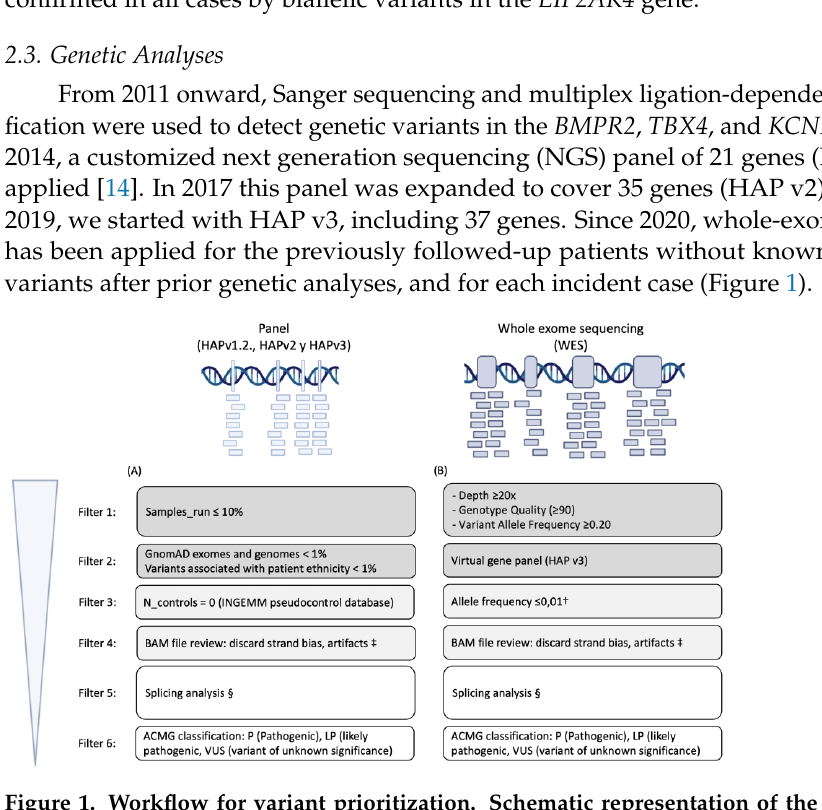
Figure 1. Workflow for variant prioritization. Schematic representation of the pipeline for ter- tiary/prioritization analysis of panel (A) and WES (B) samples . Custom NGS panels